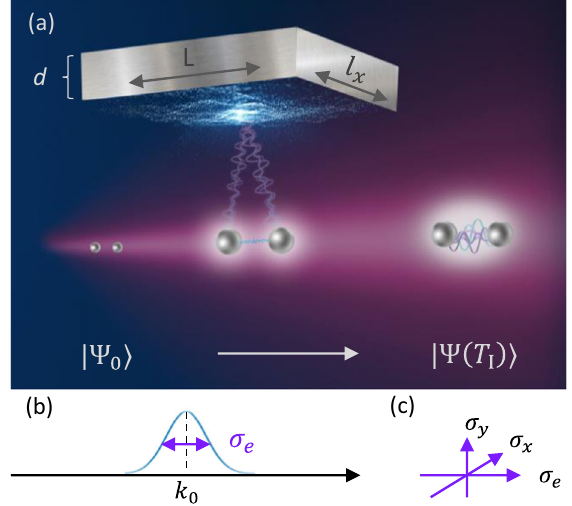
Fig. 1 Physical platform for free-electron pair correlations. a An uncorrelated electron pair Ψ 0 j i propagates parallel to the planar surface of a polariton-supporting fi lm of length L along the propagation direction, transverse width l x ≫ L , and thickness d = 1nm. b Initial distribution of the longitudinal momentum compo- nent, centered around k 0 with σ 2 spread. c Spatial orientation of the e . After an variance in the transverse momentum spread σ 2 x ; y interaction time T I , a correlated pair Ψ T I ð Þj i is obtained.